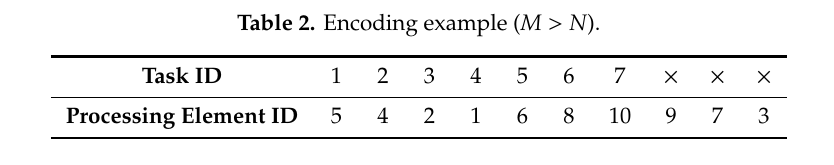
Table 3. Encoding example ( M < N